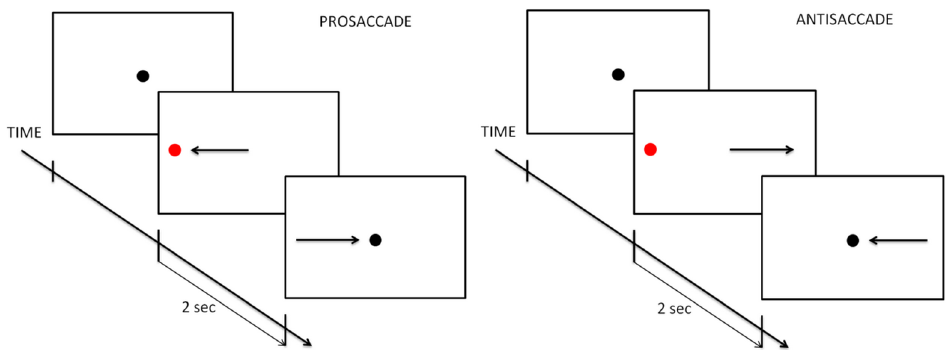
Figure 1. Eye movement tasks.